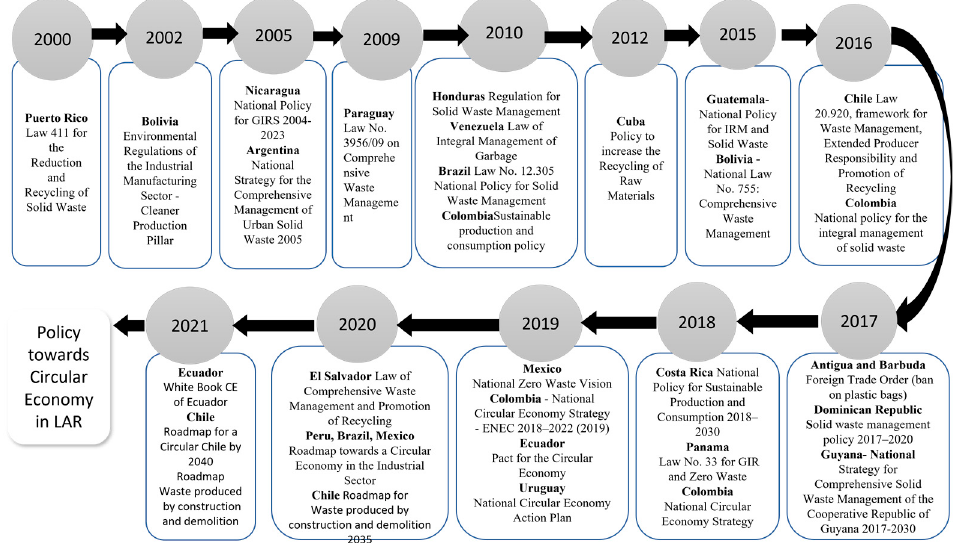
Figure 1. Timeline with the principal policies towards a CE in the LAR (Updated and adapted from [9,10]).